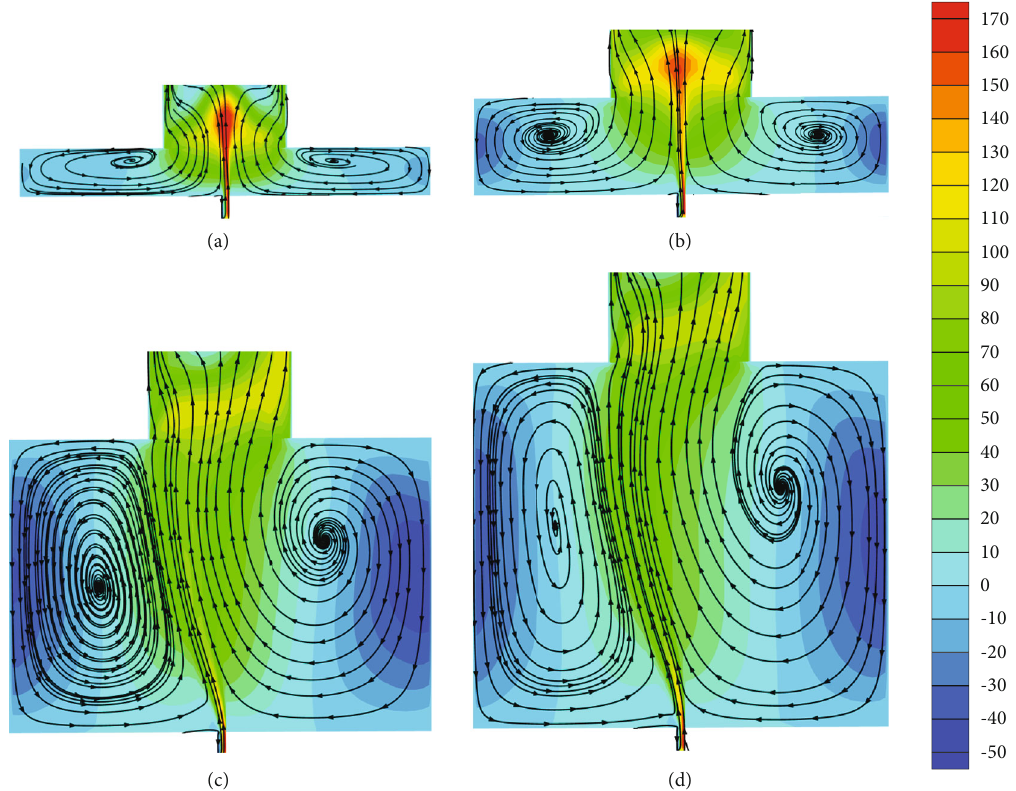
H = ð a Þ 0 : 14 , (b) 0.28, (c) r /